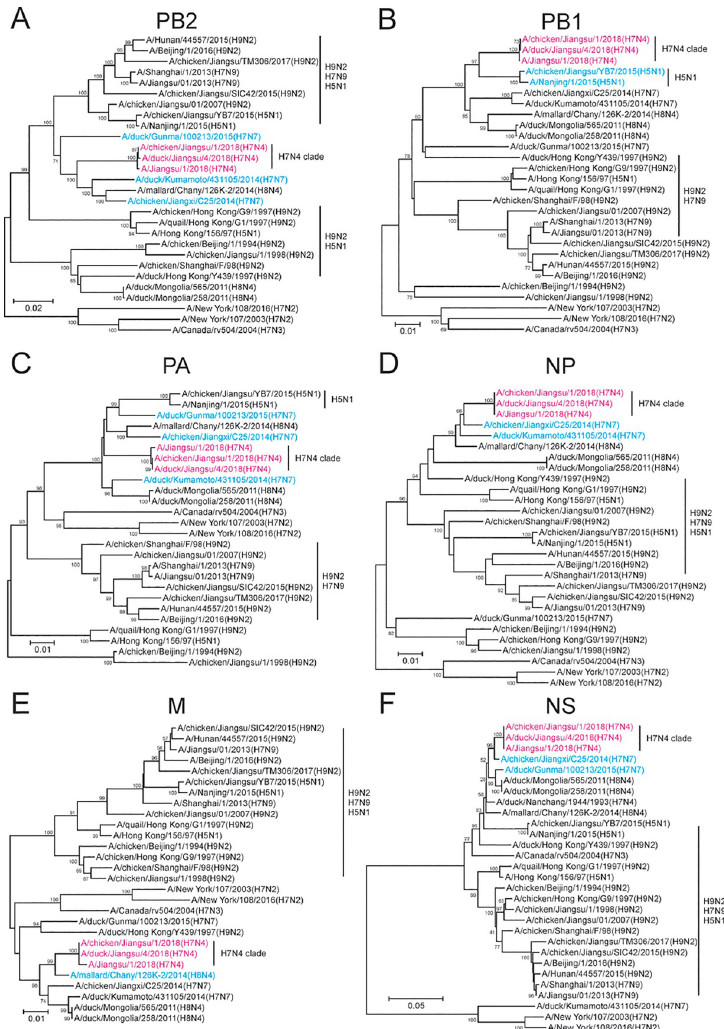
Fig 2. Phylogeny of the origins of PB2, PB1, PA, NP, M and NS segments of the novel H7N4 virus from H7N7, H8N4, and H5N1 viruses. The internal segments of the viruses were aligned and subjected to the construction of phylogenetic trees. The viruses included JS2018, A/chicken/Jiangsu/1/2018, A/duck/Jiangsu/4/2018, H7N7, and H8N4 strains identified in Fig 1, and representative avian H9N2 strains as well as human H5N1, H7N9, H7N2 and H9N2 viruses, collected in mainland China between 1994 and 2017. A) PB2; B) PB1; C) PA; D) NP; E) M; and F) NS. H7N4 viruses (magenta) and related H7N7, H8N4 and H5N1 viruses (cyan) were highlighted. For each segment, the scale bar indicates the number of nucleotide substitutions. The human H7N3 virus (A/Canada/rv504/2004 (H7N3)), which was never identified in Europe and Asia, was used as outgroup control.